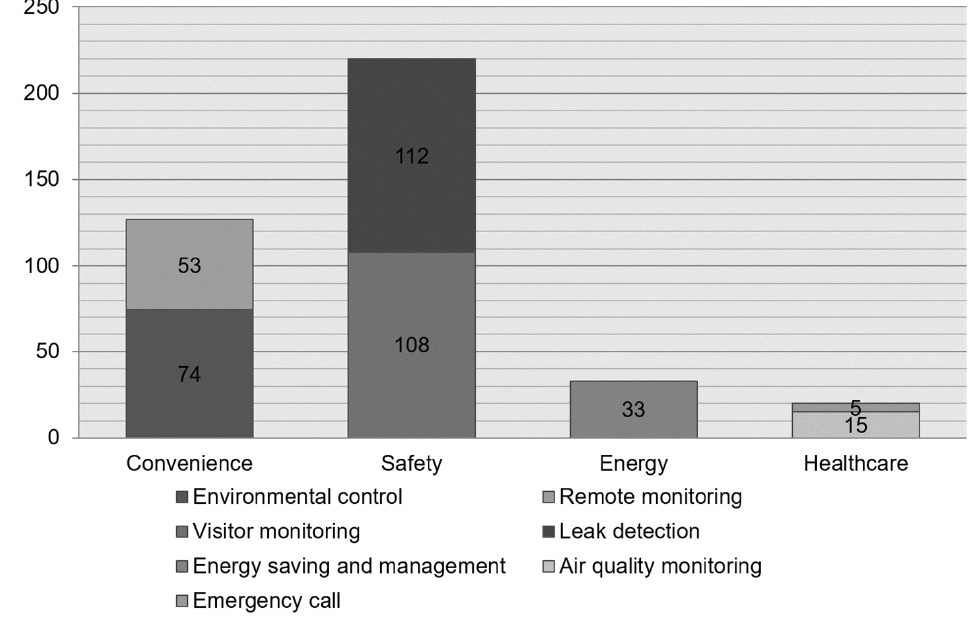
Figure 2. Results of the service preference test (N = 400).